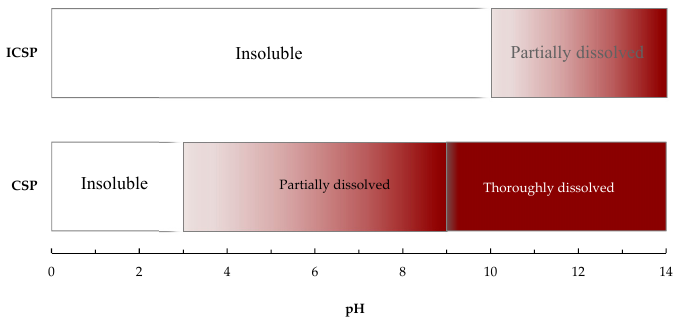
Figure 2. Solubility tendency of CSP and insolubilized chestnut shell pigment (ICSP) in aqueous media at various pH.